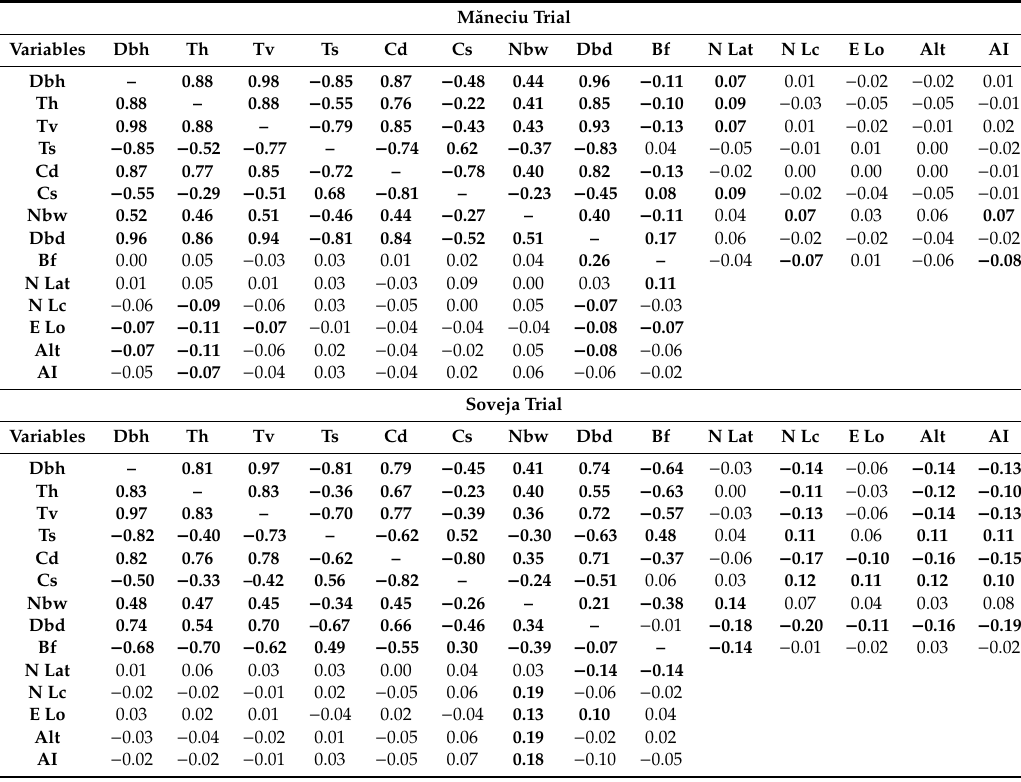
Table 4. Correlations between analysed traits and between traits and geographic and climatic gradients of provenances’ origin at crown form level ( pendula up to – and pyramidalis , down to